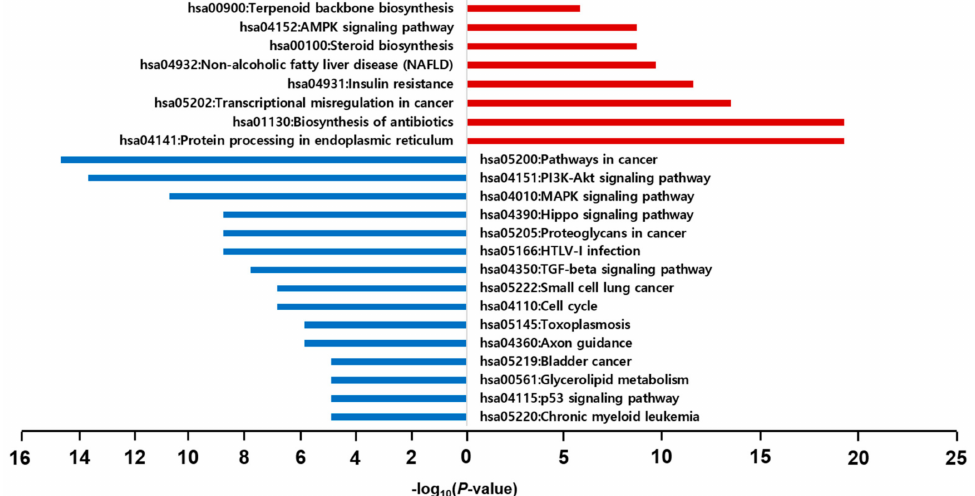
Figure 5. Results of KEGG pathway enrichment analysis. The red and blue bars represent the results of KEGG pathway analysis using upregulated genes and downregulated genes,